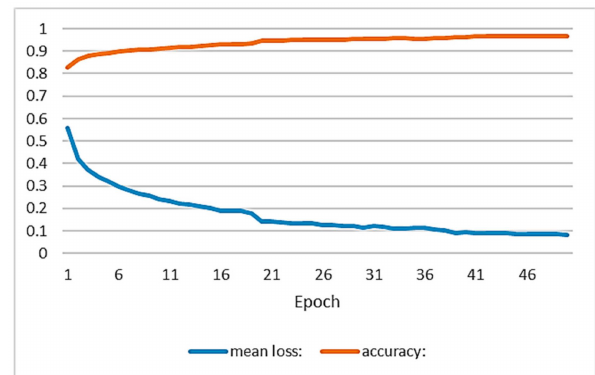
Figure 5. Evolution curves of accuracy (orange) and loss (blue) during training.